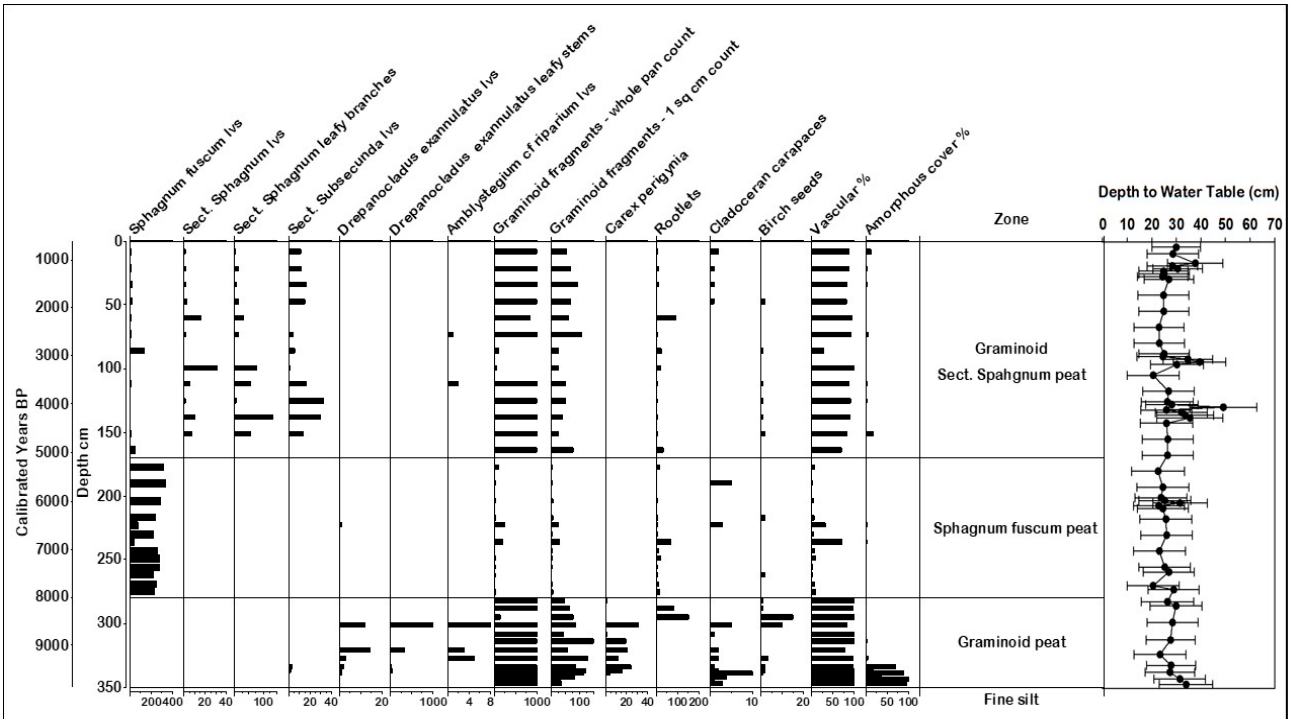
Figure 6. Cove Fen macrofossils. The chronology is based on linear interpolation with nine AMS radiocarbon dates. Particle count units are particles/cm 2 ; vascular composition and amorphous gel cover are percentages. Right-hand column shows modeled depth-to-water table from testate amoebae transfer functions; errors are +/ − 2 SE. (See Supplementary Materials Figure S3 for testate amoebae taxa profiles.) At 7.9 ka, there is a pronounced shift from wet graminoid vegetation to dry hummock-forming Sphagnum fuscum , which is likely due to normal autogenic succession as the vertical accumulation of peat progresses. The shift back to wet graminoids at 4.8 ka, however, is likely due to a wetter late-Holocene